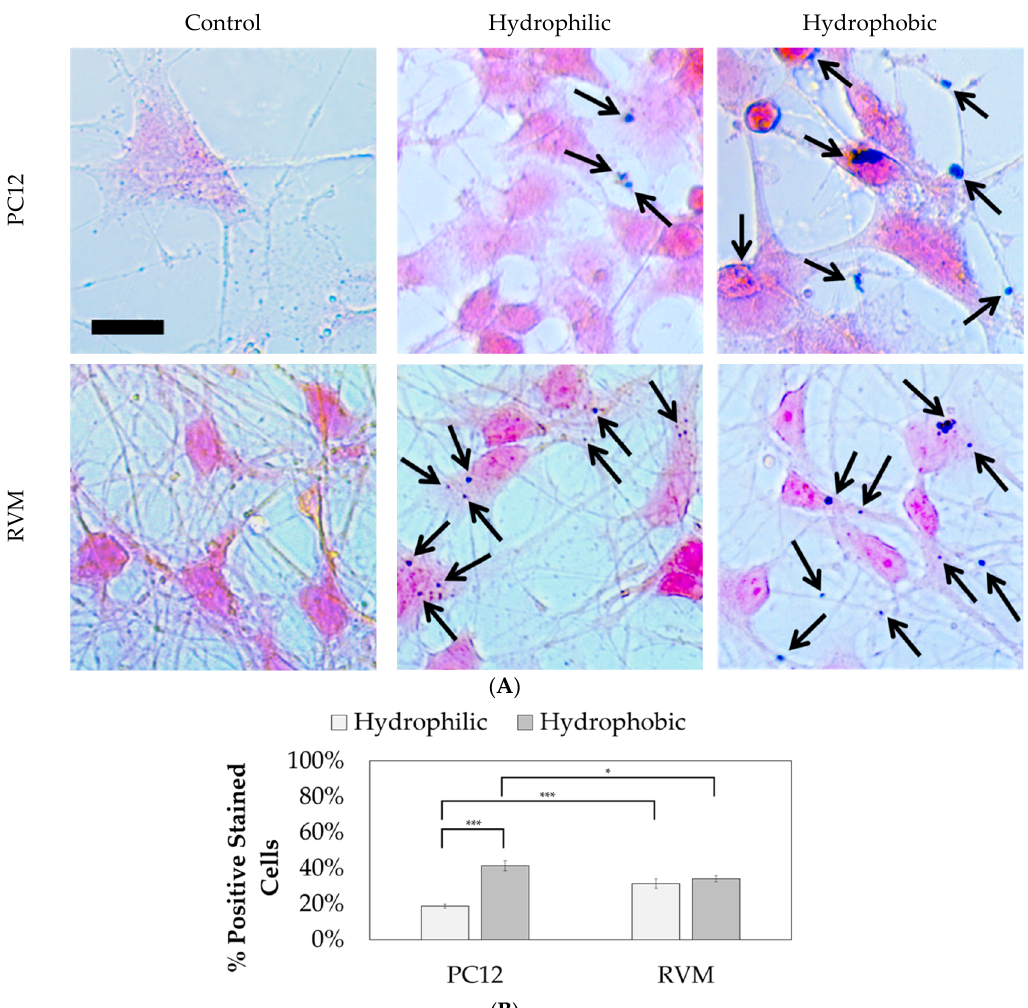
Figure 11. Brightfield microscopy images of PC12 and RVM cells after 24 h of nanoparticle treatment followed by 7 day differentiation. ( A ) Prussian blue visualizes the remaining iron oxide and nuclear fast red is used as the counterstain. Black arrows indicate iron oxide particles associated with the cells. Scale bar = 10 µm. ( B ) Prussian blue positive cell count analysis results. N ≥ 460 cells over 25 images per condition. * p < 0.05, *** p < 0.001.